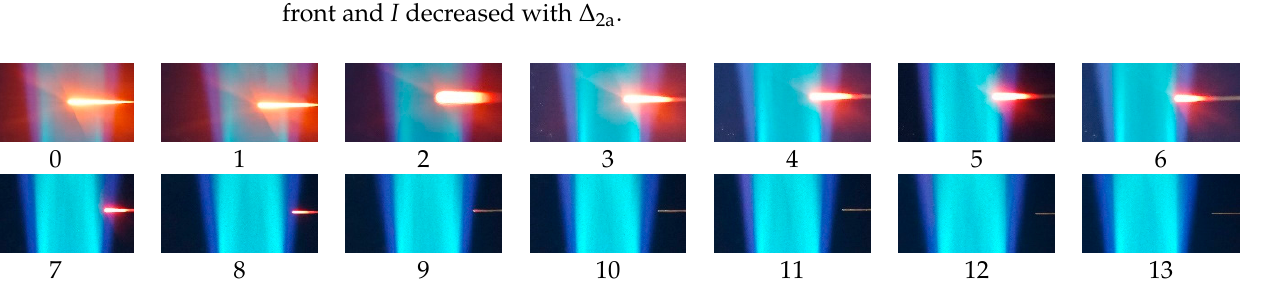
Figure 8. Zonal division of the Bunsen flame.